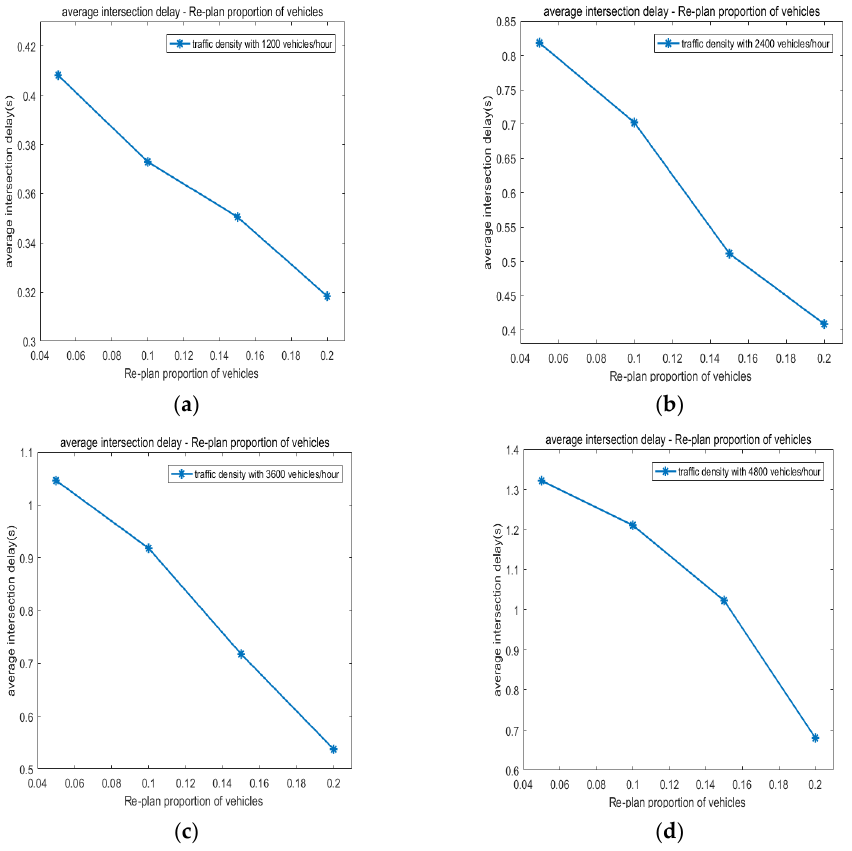
Figure 11. The relation between the parameter m and the average intersection delay with different traffic densities: ( a ) f 1 = 1200 veh/h, ( b ) f 2 = 2400 veh/h, ( c ) f 3 = 2400 veh/h, ( d ) f 4 = 4800 h .